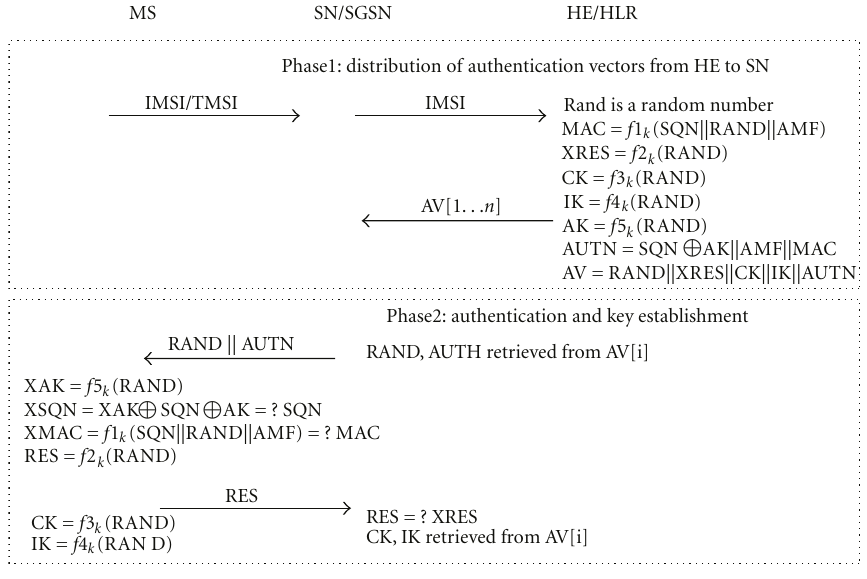
Figure 3: UMTS-AKA-protocol.